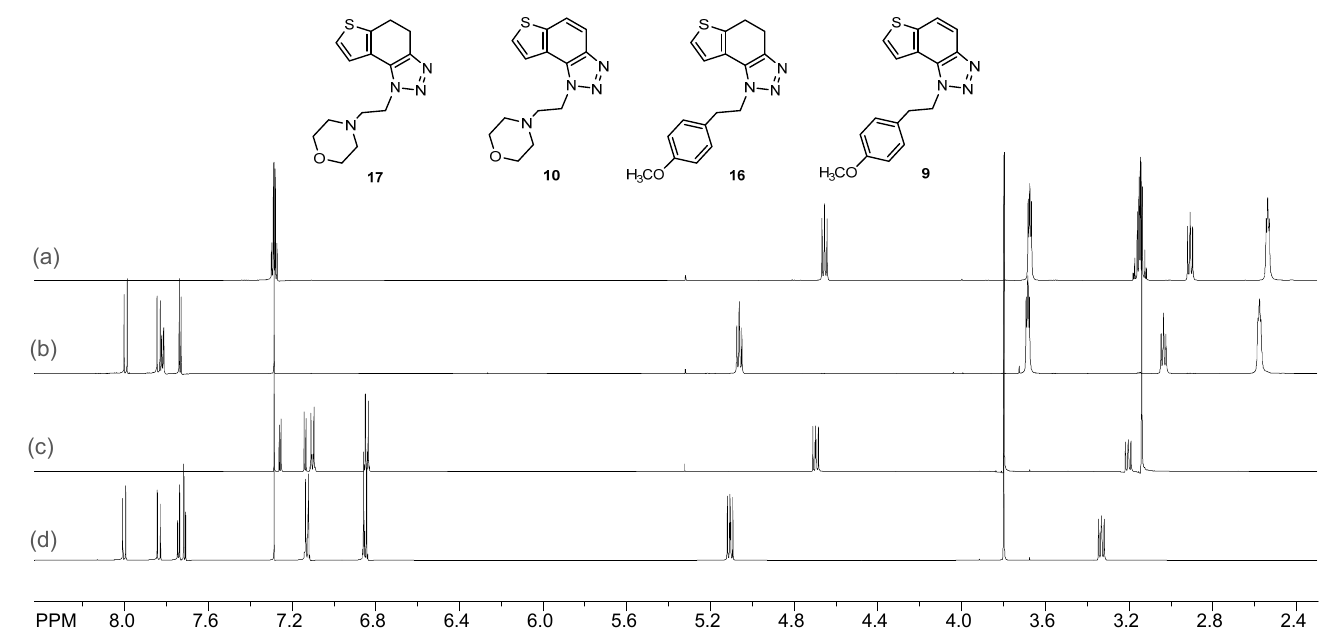
Figure 2. Comparison of the 1 H NMR spectra (CDCl 3 ) of investigated compounds ( a ) 17 ; ( b ) 10 ; ( c ) 16 ; ( d ) 9 .